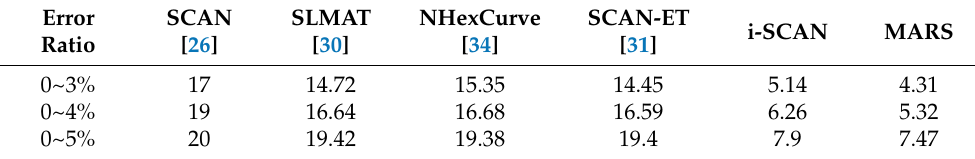
Table 1. The size of the positioning area for different non-ideal signal error ratios (m 2 ).